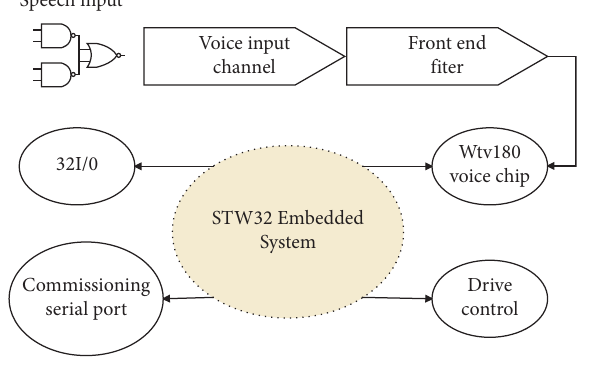
Figure 13: System hardware part